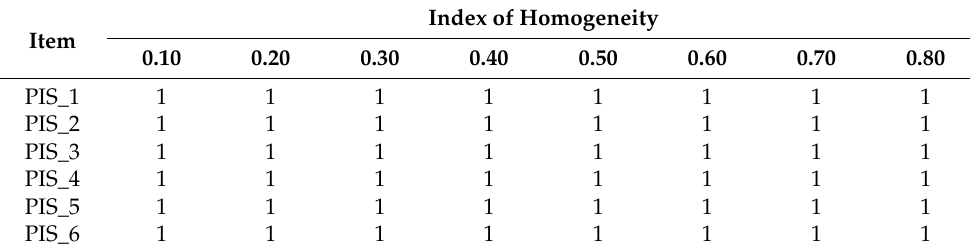
Table 2. Scalability analysis for different homogeneity indices.